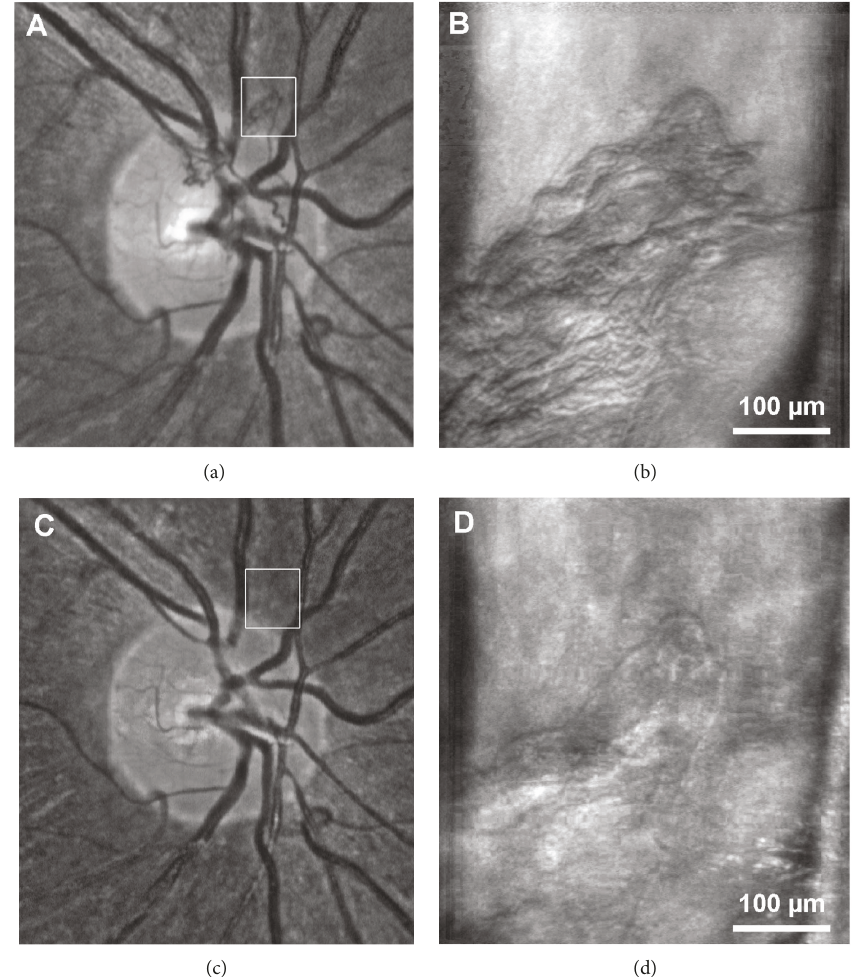
Figure 4: Response of proliferative diabetic retinopathy to anti-VEGF therapy on AOSLO. (a) Fundus photograph of neovascularization at the optic disc (NVD). (b) MSL AOSLO image of the area highlighted by the white box in (a). (c, d) Same NVD 4 weeks after administration of intravitreal ranibizumab. The NVD can no longer be identi fi ed in the infrared image; however, AOSLO imaging reveals the persistence of an involuted neovascular